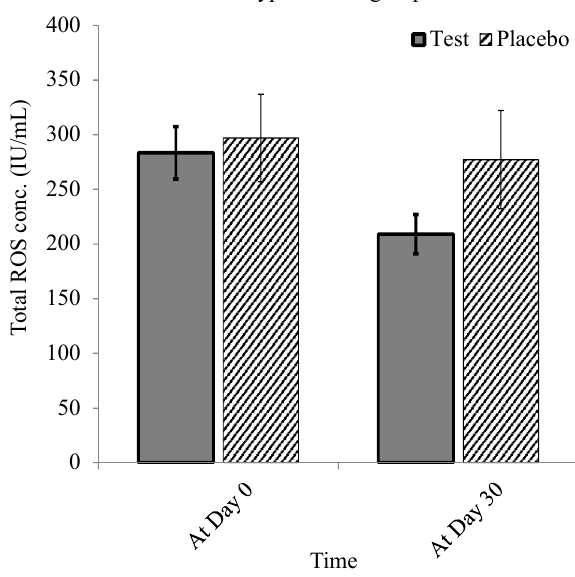
Fig. 2. Total ROS levels for hypertensive participants receiving anthocyanin extract or placebo at day 0 and day 30. Values are expressed as mean ±SD